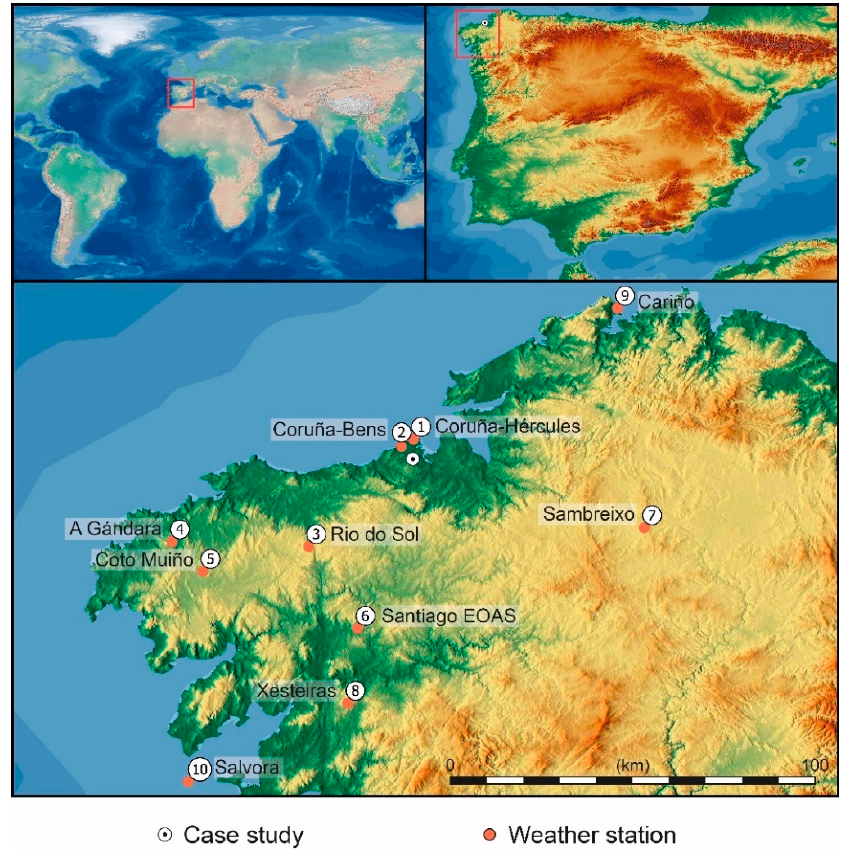
Figure 1. Location of the case study and the weather stations used. Further information of the weather stations can be found in Table 3.